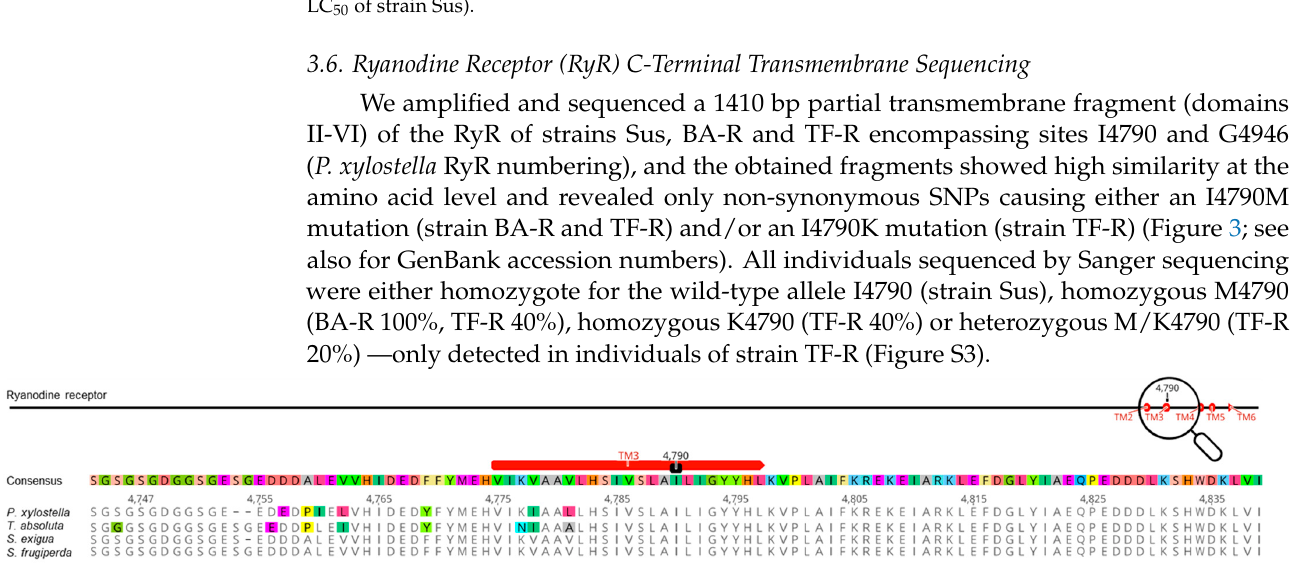
50 of strain BA-R/TF-R divided by the